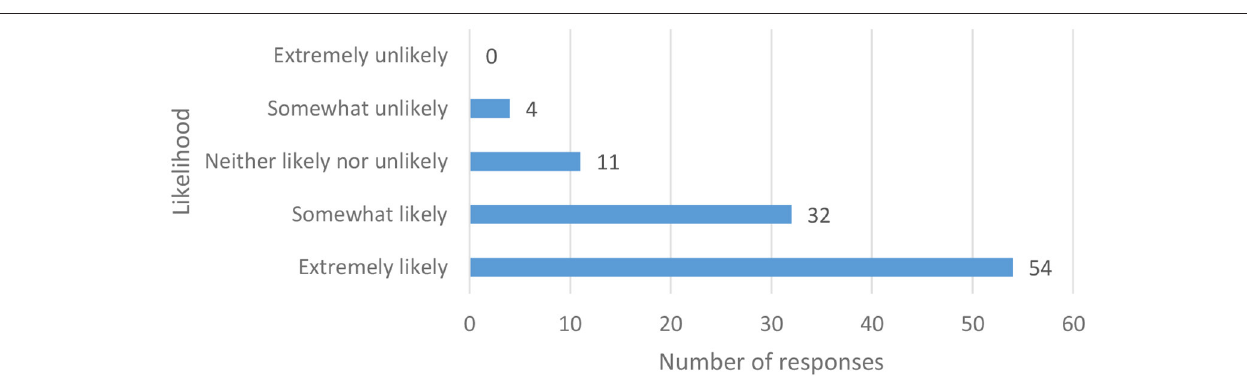
Figure A2 | Likelihood of volunteering in sport events post-pandemic.